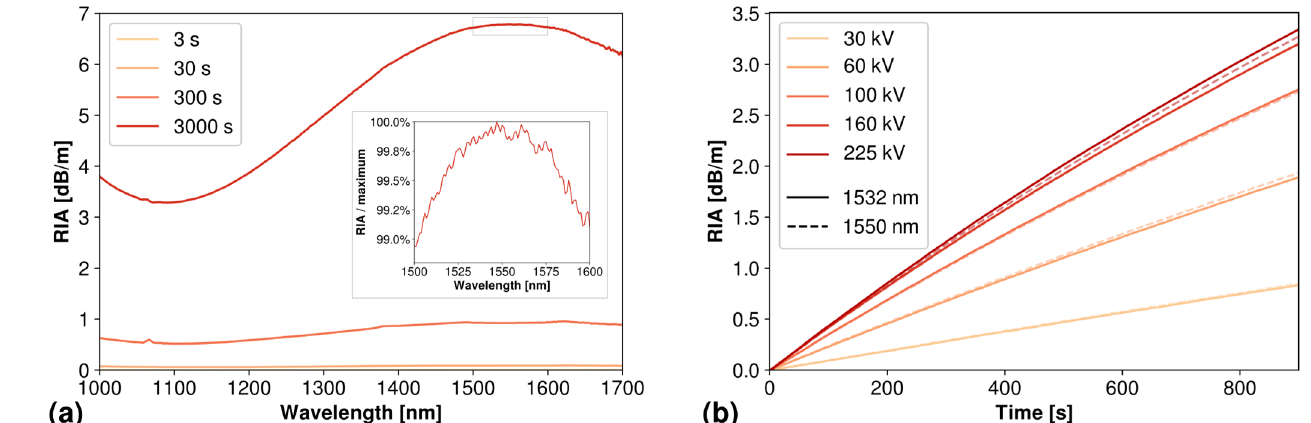
Figure 8. ( a ) Spectral RIA of the optical fiber irradiated during 3, 30, 300 and 3000 s with a tube voltage of 100 kV. Inset magnifies the framed area at 3000 s between 1500 nm and 1600 nm, normalized by maximum. ( b ) Evolution of optical fiber RIA at 1532 nm and 1550 nm according to irradiation time, at different X-ray tube voltages.